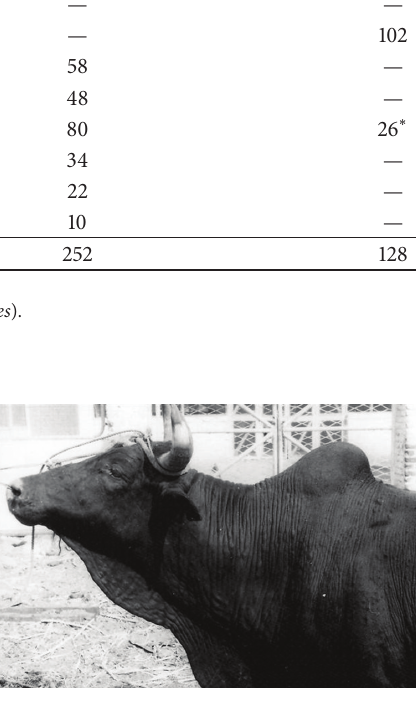
Figure 3: Simultaneous skin and meibomian gland demodicosis. Note swelling of the eyelids and nodules on the upper eyelid arranged in a linear